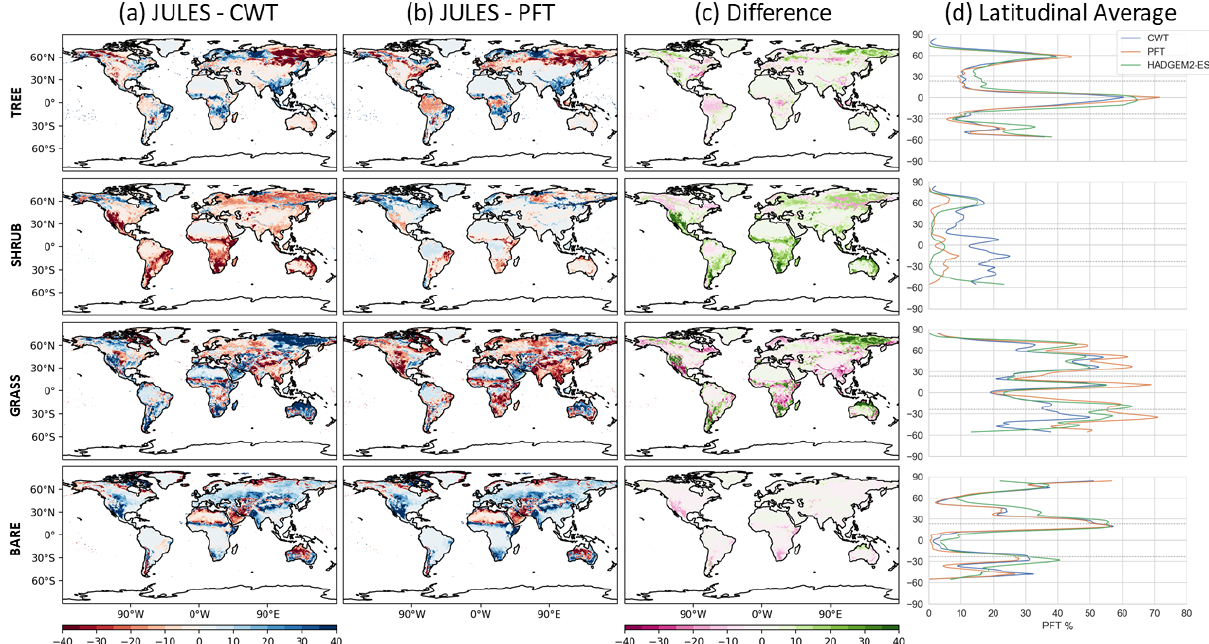
Figure 5. Comparison of JULES PFT distributions to both the CWT (PFT global ) and PFT (PFT local ) products for major vegetation types. Rows show each major surface type (tree, shrub, grass, bare), whilst the rows show (a) the JULES vegetation distribution compared to the global CWT, (b) the same compared to new PFT local distributions, (c) the difference between panels (a) and (b) , where green (pink) indicates positive or negative anomalies evaluated closer to 0 (further away from 0) using new PFT local distributions, and (d) absolute latitudinal average fractions for each major vegetation type from CWT, PFT, and